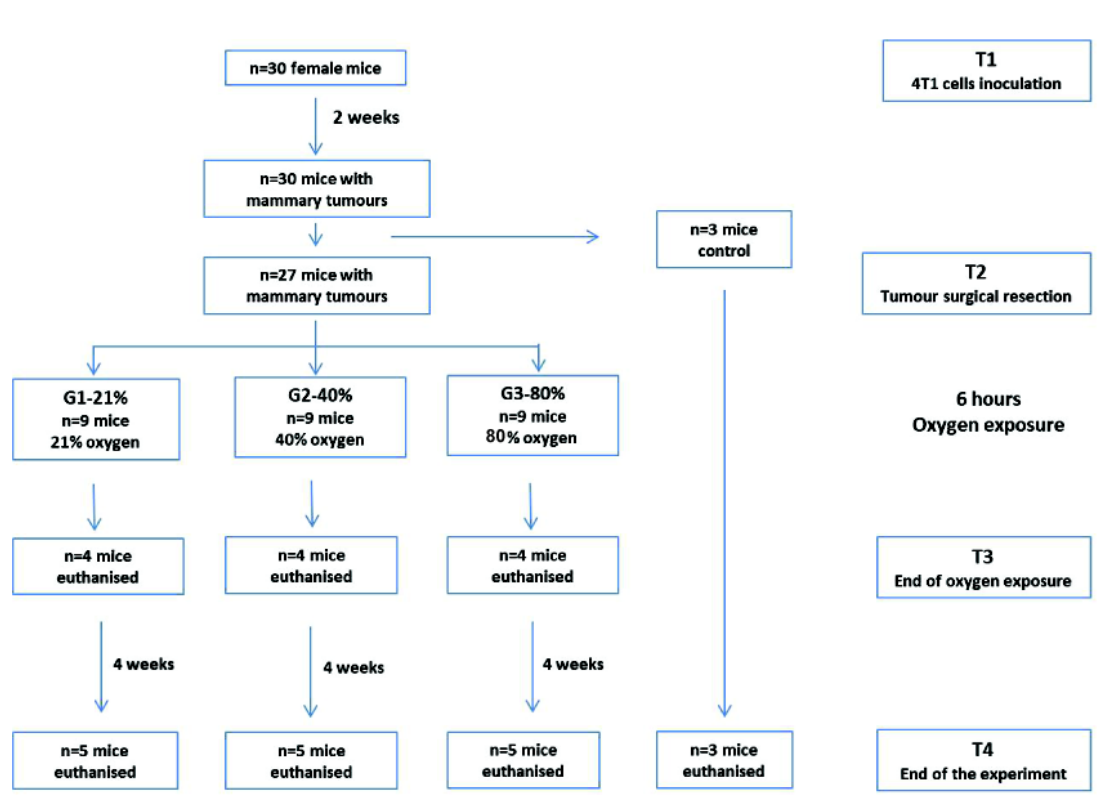
Figure 8. In vivo experimental protocol.